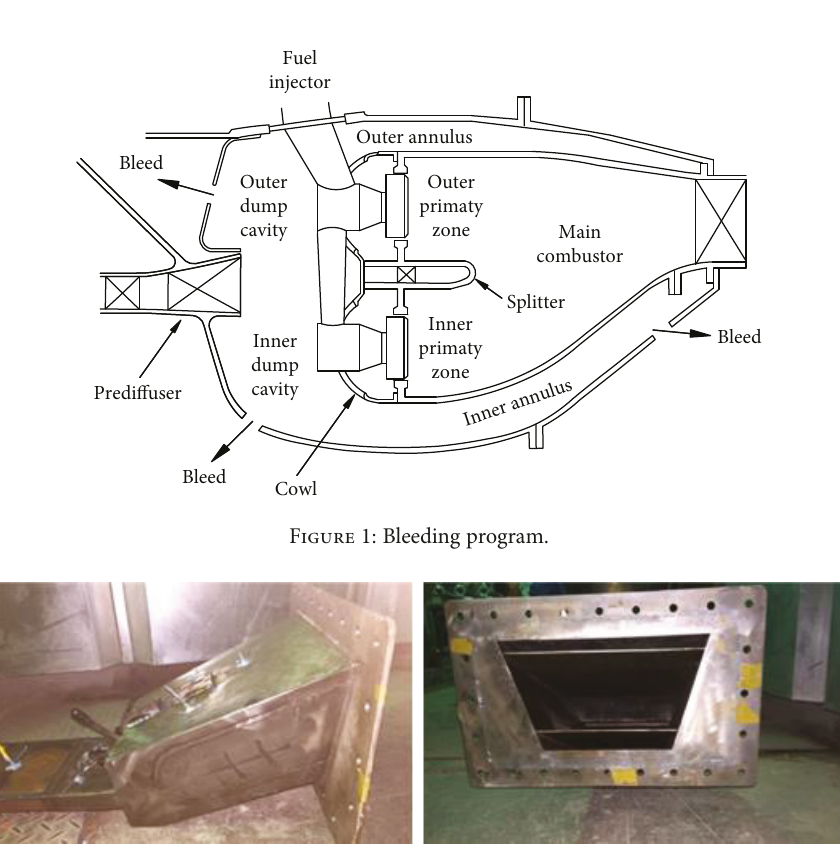
Figure 2: Test region of dump di ff user.